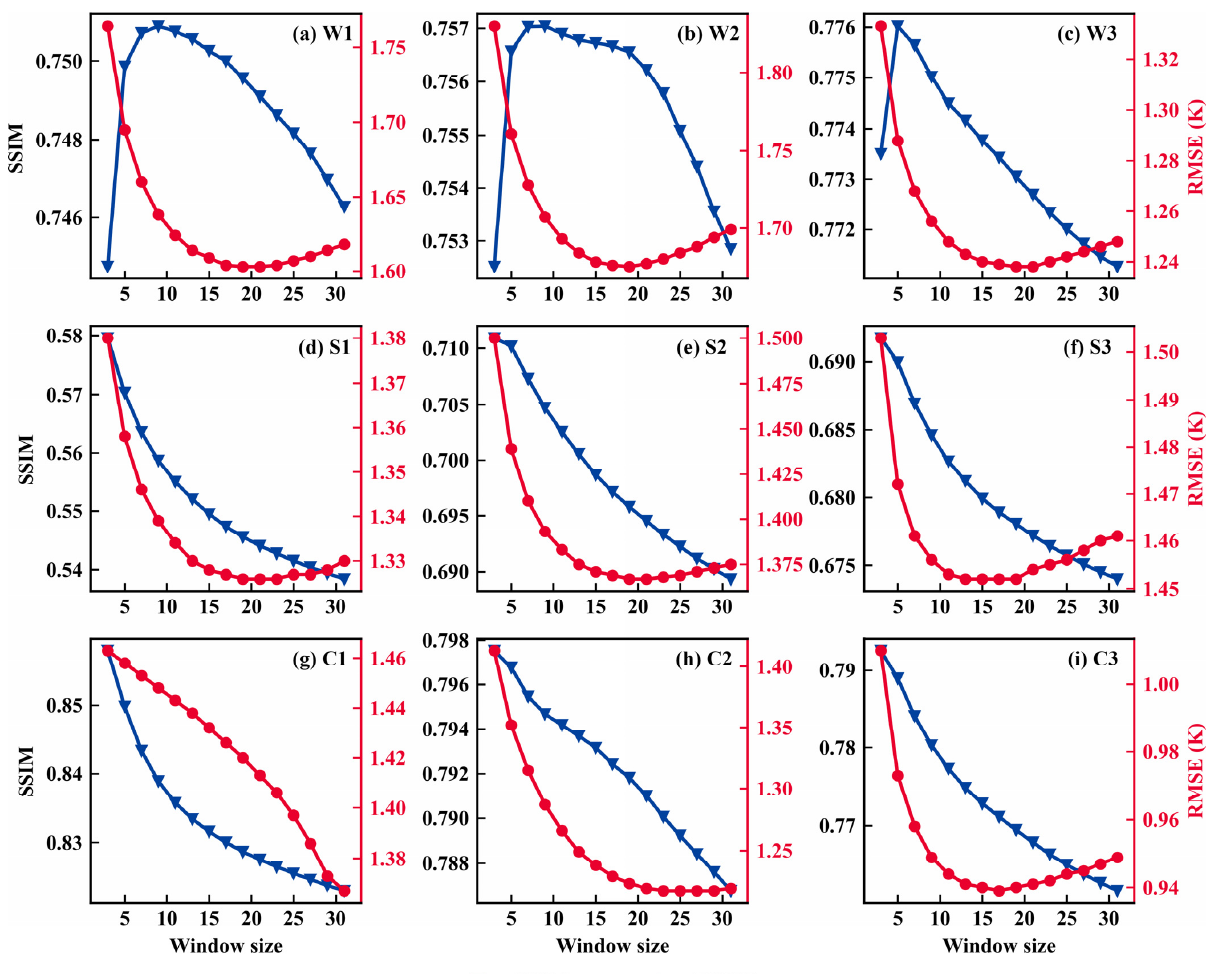
Figure 4. Line plots of the RMSEs and SSIMs of downscaled LST images were obtained using different window sizes in fine-resolution images. The labels ( a – i ) represent the image IDs of W1, W2, W3, S1, S2, S3, C1, C2, and C3.